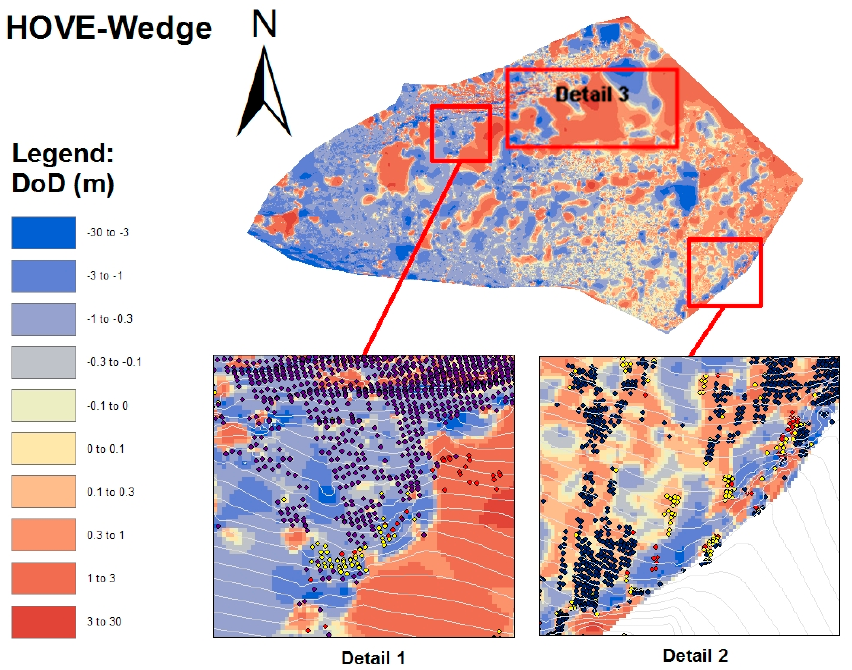
Figure 10. Detail of the test area.